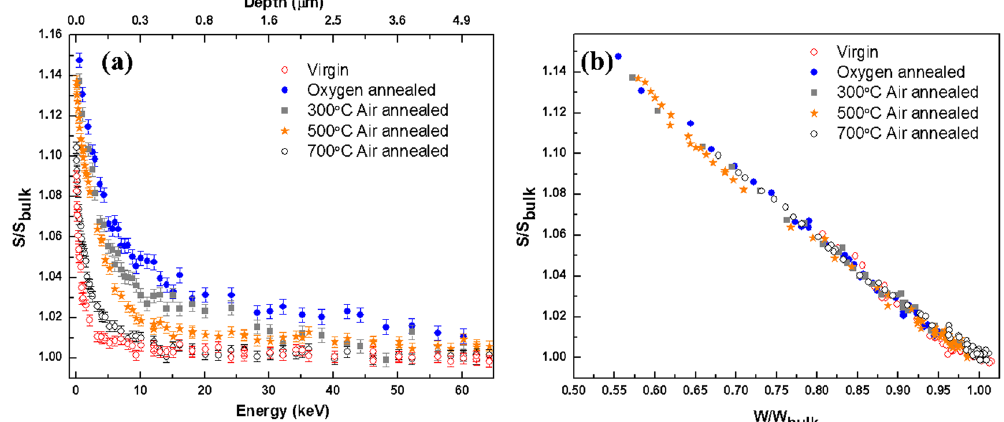
Figure 6. Positron data ( a ) (S vs Energy/depth) ( b ) S vs W, of an air-annealed (1 hour) CVT crystal that was then oxygen annealed at 1100 °C.